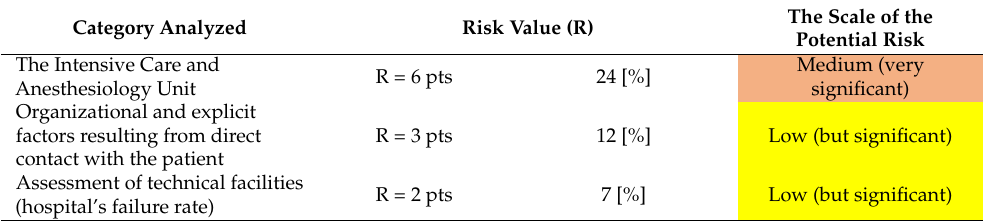
Table 11. Potential risk or exposure for the hospitalized patient that may be caused by the Intensive Care and Anesthesiology Unit, technical facilities (hospital’s failure rate) as well as organizational and explicit factors resulting from direct contact with the